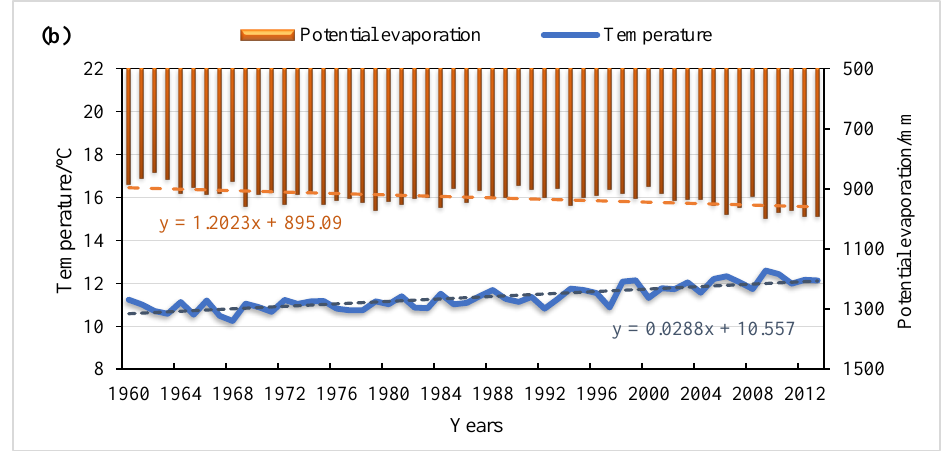
Figure 3. Hydrological and meteorological data of the Lancang River basin (1960 − 2013). ( a ) Hydro- logical data and ( b ) meteorological data.